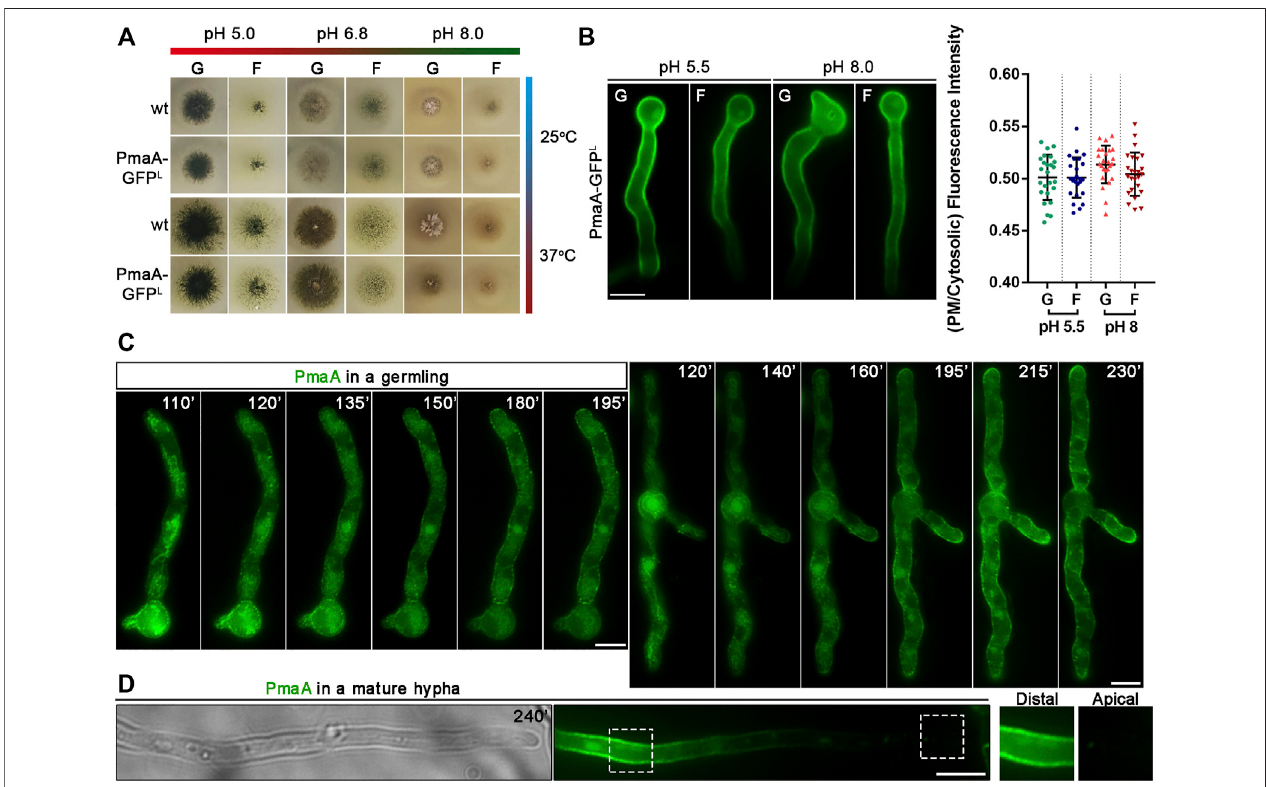
FIGURE 2 | Growth phenotypes of strains expressing PmaA-GFP and subcellular localization at different development stages or pH. (A) Comparative growth test analysis of a strain expressing the GFP-tagged version of PmaA with an isogenic wild-type control strain on selected C sources [G: 1% (w/v) glucose; F: 0.1% (w/v) fructose] at 25 ° C or 37 ° C, at pH 5, 6.8, or 8. It is noted that the growth rate and morphology of the strain expressing the in-locus GFP-tagged version of PmaA are identical to those of the control strain, in all conditions tested. (B) Epi fl uorescence microscopy of a strain expressing the in-locus GFP-tagged version of PmaA at acidic (pH 5.5) or alkaline pH (pH 8) with glucose [G: 1% (w/v)] or fructose [F: 0.1% (w/v)] as the sole C source. It is noted that PmaA-GFP fl uorescence is identical in all conditions. Results shown are con fi rmed by quanti fi cation (right panel) of PmaA-GFP PM/cytosolic intensity ratios for all conditions tested (for details, see Materials and Methods ).MeanintensityratiosofPmaA-GFPare0.501±0.022inglucosepH5.5,0.501±0.019infructosepH5.5,0.513±0.018inglucosepH8,and0.504±0.021 in fructose pH 8. For the statistical analysis, Tukey ’ s multiple comparison test was performed (one-way ANOVA). No statistically signi fi cant differences were found betweendifferentconditions.Biological/technicalreplicates foreach condition: 2/25. (C) Epi fl uorescencemicroscopyofnewlysynthesizedPmaA-GFPintwogermlings after derepression of transcription (110 – 230 min). PmaA appears fi rstly in a membranous mesh and various cytosolic puncta (110 – 140 min) and steadily labels cortical puncta and fi nally the entire PM. (D) In mature hyphae, PmaA is practically no longer found in the PM of the apical region. Scale bars: 5 μ m.